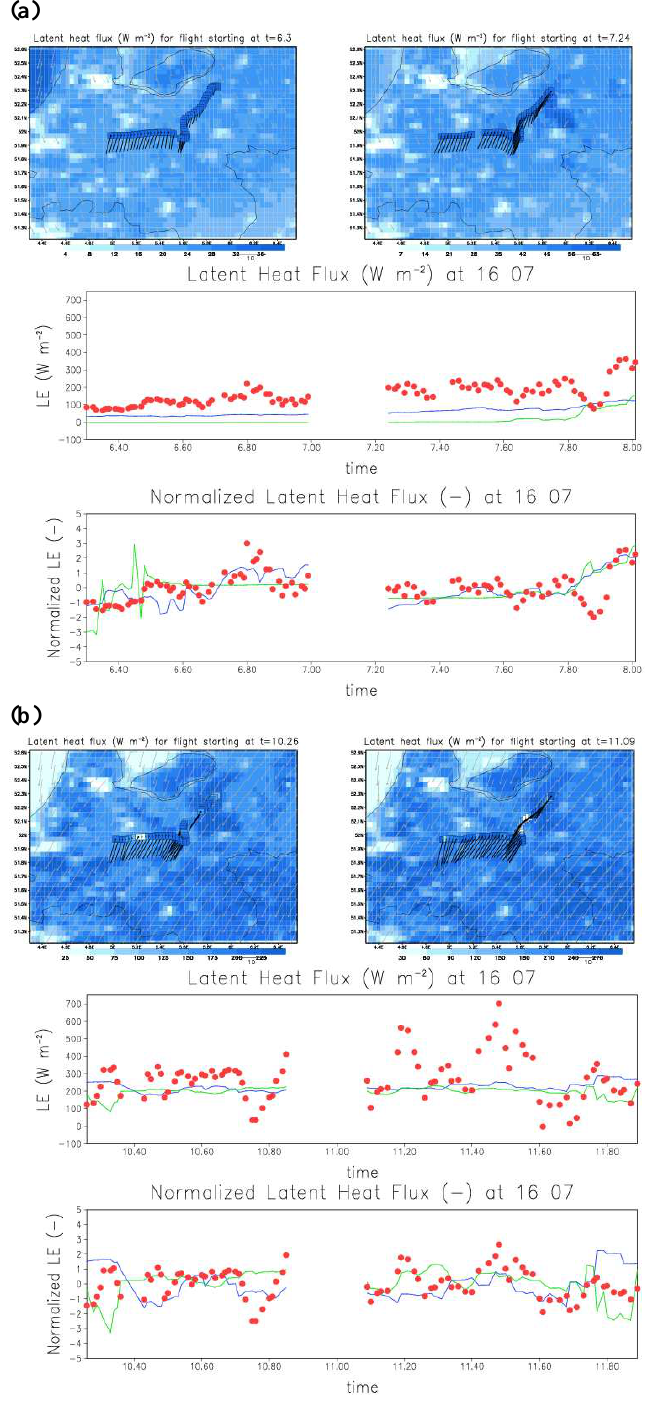
Fig. 10. Spatial comparison of latent heat fluxes (Wm − 2 ) against aircraft observations, for the flights on 16 July 2002 – (a) : 06.28UTC, 07.22UTC; (b) : 10:25UTC, 11:07UTC. The maps show simulated latent heat flux at the surface and wind vectors (gray). Superimposed on that is the flight track with observed fluxes (squares) in the same colour coding as the background map, plus aircraft observed windvectors (black). The lower plots in (a) and (b). show the aircraft observed fluxes (red dots), simulated fluxes at the surface (dark blue) and at flying altitude (green) in terms of both their absolute values and anomalies of the flux which is defined as the deviation from the average of the total flight track divided by the standard deviation. Simulated fluxes have been interpolated from model grid to exact location and time of flight overpass. The early flight moves from NE to SW, the return flight from SW to NE. So in the scatter plot the left side is the NE the middle the SW and the right side NE